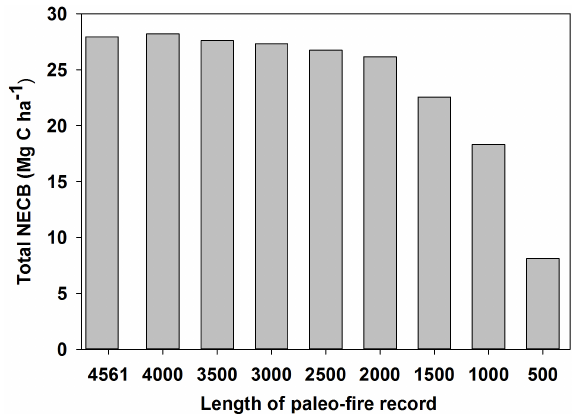
Figure 5. Total NECB (NPP – R h – fire emissions) for the 4561- year simulated period and for each of the partially paleo-informed scenarios (Paleo_500, Paleo_1000, etc., in Fig. 1). Each partially paleo-informed scenario branches from the equilibrium scenario in the year indicated on the x axis. For example, the 500-year record only includes fires that occurred in the most recent 500 years of the paleo-fire record